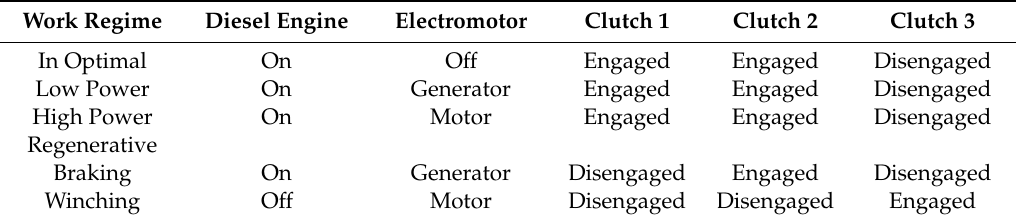
Table 2. Operating modes of hybrid vehicle.